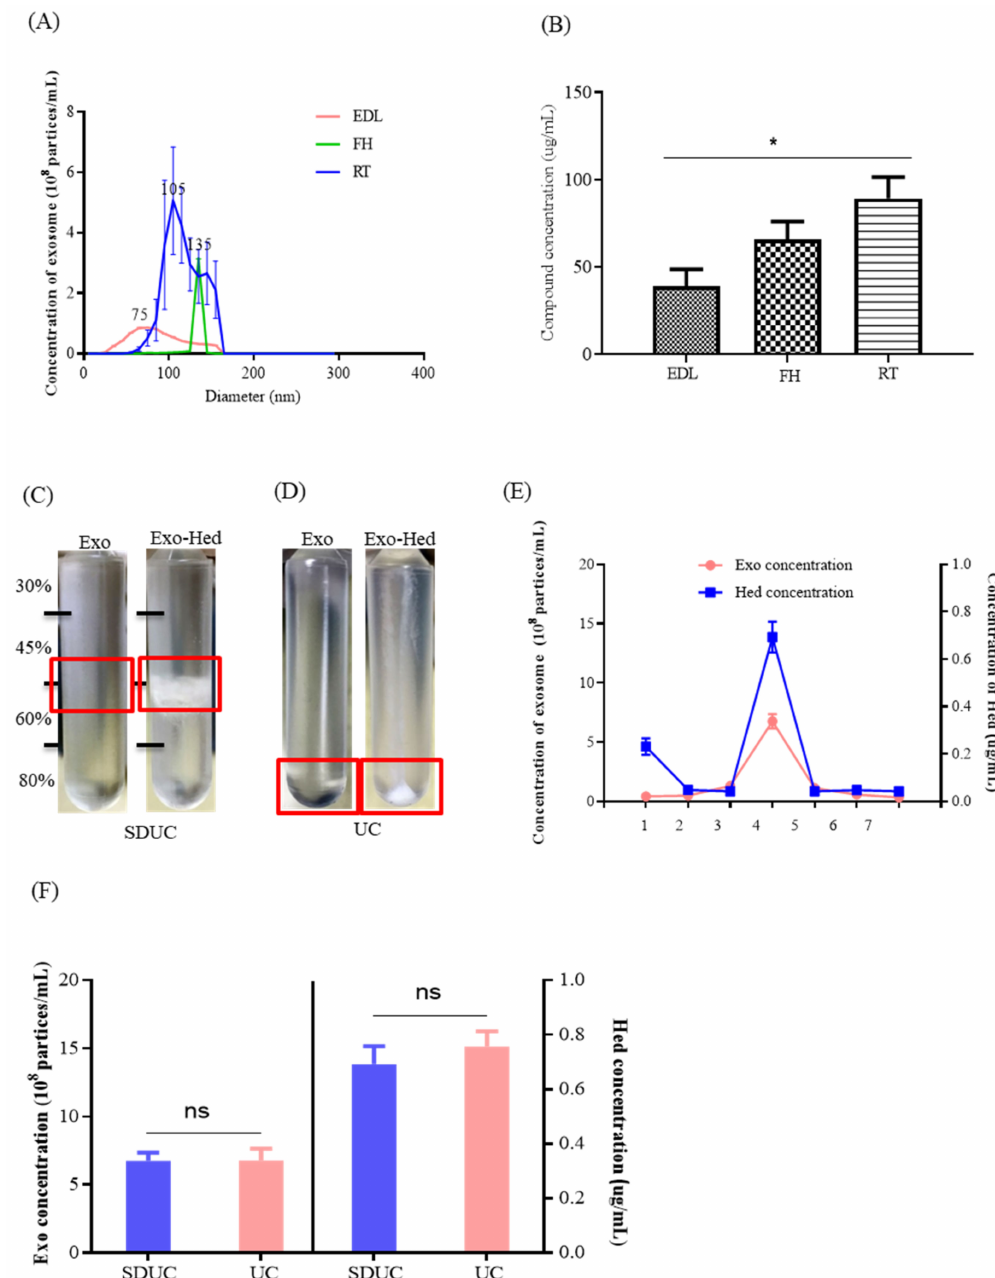
Figure 2. Optimization of the different extraction and compound loading methods for the exosomes. ( A ) The sizes (diameter, nm) of the exosomes obtained by the three different methods were measured and compared by NTA. ( B ) UHPLC-MS was adopted to detect the herbal Hed concentration of the exosomes loaded by the three selected compound cargo loading methods (EDL, FH and RT). ( C ) Pictures were captured to show the presence of the precipitated Exo and Exo-Hed vacuoles extracted by the SDUC method. ( D ) Pictures were captured to show the presence of the precipitated Exo and Exo-Hed vacuoles extracted by the UC method. ( E ) The Exo concentration and the Hed concentration of the seven fractions obtained by SDUC were examined by NTA and UHPLC-MS, respectively. ( F ) The Exo concentration and Hed concentration obtained by SDUC and UC were detected by NTA and UHPLC-MS, respectively. All of the experiments were performed as three independent experiments. One-way ANOVA was used to compare the data, * p <